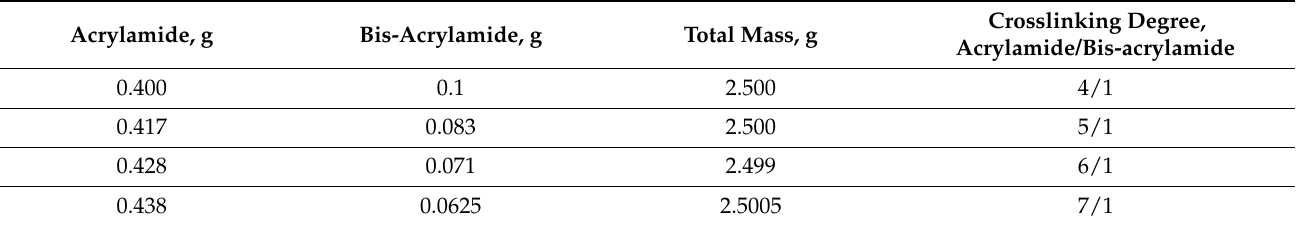
Table 1. Main ingredient quantities for the preparation of polyacrylamide hydrogels with various crosslinking degrees.